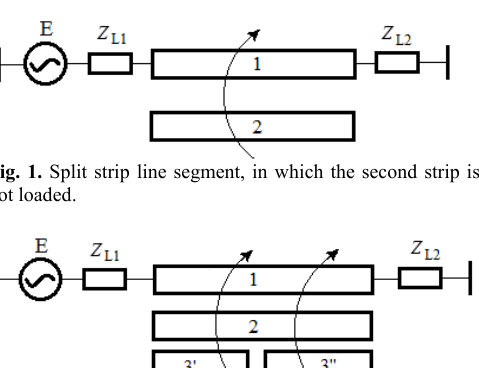
Fig. 3. Split strip line segment with inserted strip 3, having a strong electromagnetic coupling with strips 1 and 2 and divided by a transverse gap into 2 parts 3 "and 3".